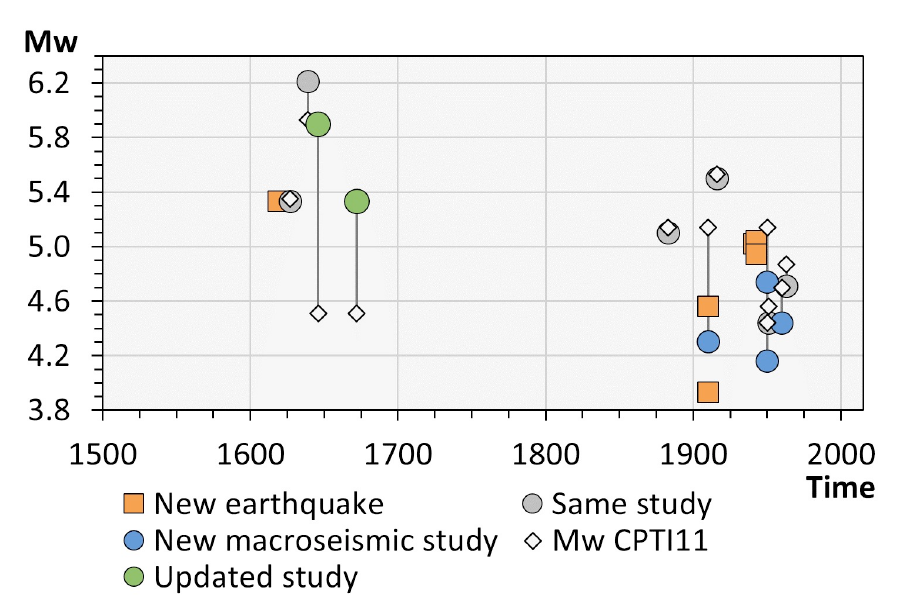
Figure 3: Magnitude variations from CPTI11 to CPTI15 deriving from the improved